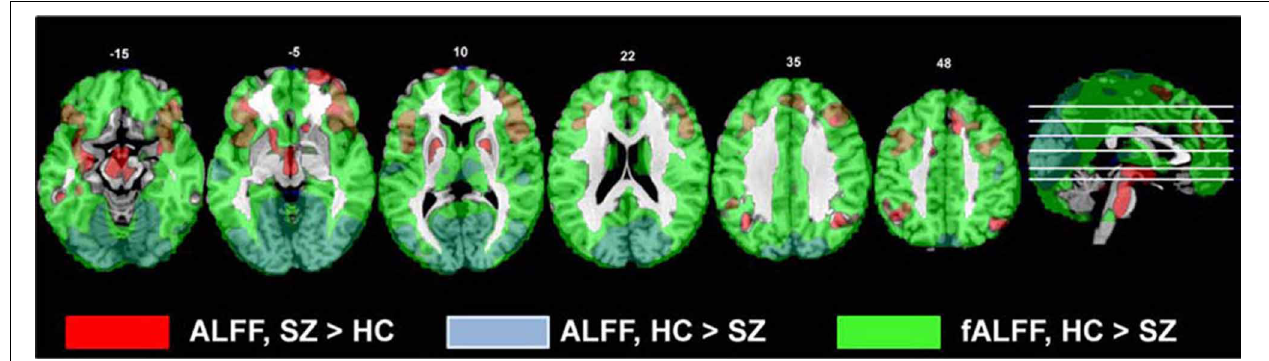
FIGURE 9 | The comparison of the original ALFF and fALFF findings for the HC > SZ and SZ vs. HC contrasts. All contrasts are thresholded at t > 2 . 5; the original ALFF SZ > HC results are in red, the original ALFF HC > SZ results are blue, and the original fALFF HC > SZ results are in